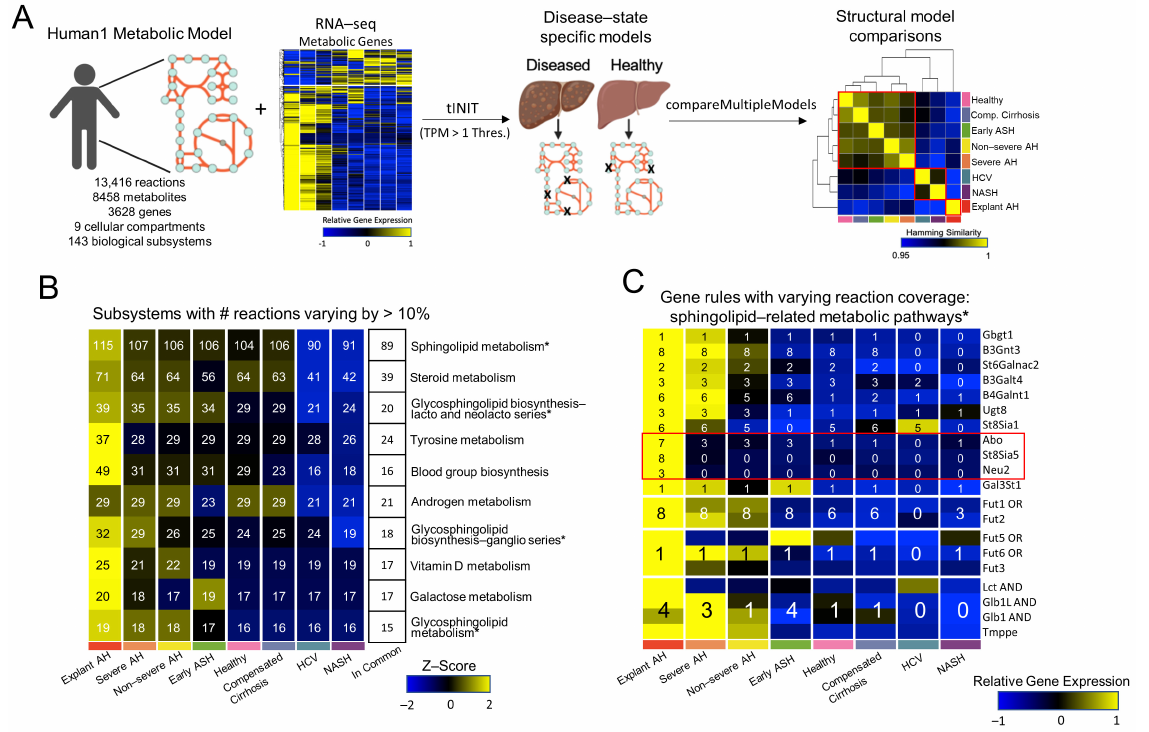
Figure 2. GEM generation and structural analysis. ( A ) Workflow describing the process of generating GEMs by integrating the generic Human1 metabolic model with the RNA seq data from Figure 1C by tINIT, using a TPM threshold of 1, and then making structural comparisons across models using the hamming similarity metric. ( B ) The top 10 subsystems with the number of reactions varying across any two GEMs by at least 10%. The number of reactions is shown for the top 10 subsystems for each model. The reactions in common across all models for each subsystem is shown. Subsystems are sorted by the total number of reactions within each subsystem. ( C ) The reactions that were not in commons across all models and belonged to sphingolipid-related metabolic pathways in Figure 2B were identified. The gene expressions encoding the gene rules from these reactions are shown. The number of reactions for each gene rule for each model is overlaid. * denotes a subsystem that is a sphingolipid-related metabolic pathway in Figure 2B.